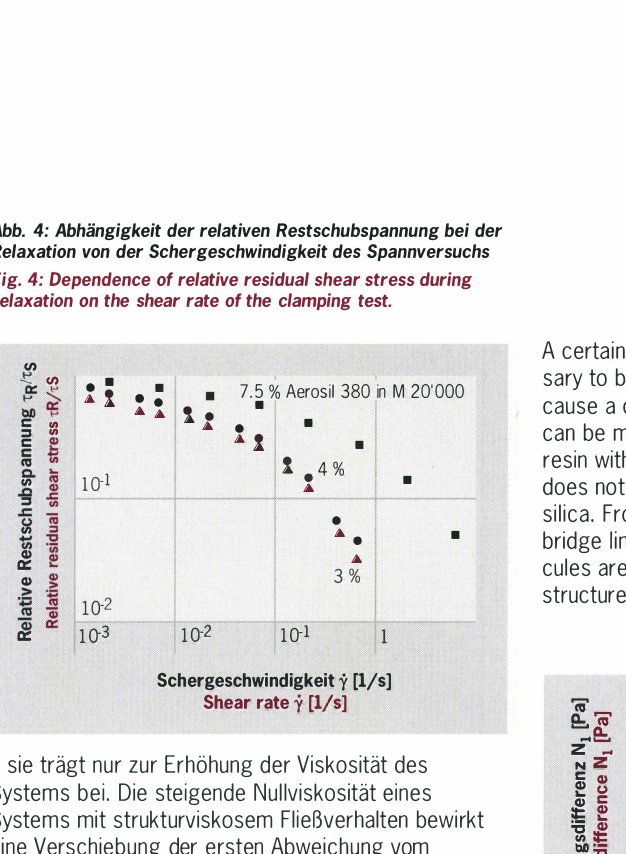
Abb. 5: Abhiingigkeit der ersten Normalspannungsdiffe­ renz von der Schergeschwin­ digkeit Fig. 5: Dependence of the first normal stress difference on shear